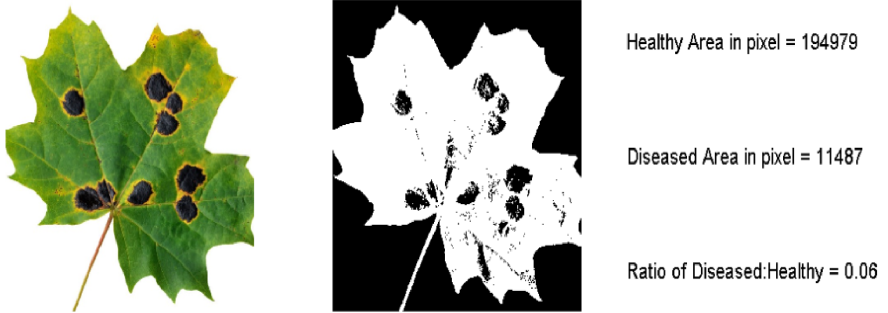
Figure 6. Analysis of a diseased maple leaf, ARIA’s flexible mainframe will allow multiple uses of the program beyond root phenotyping.